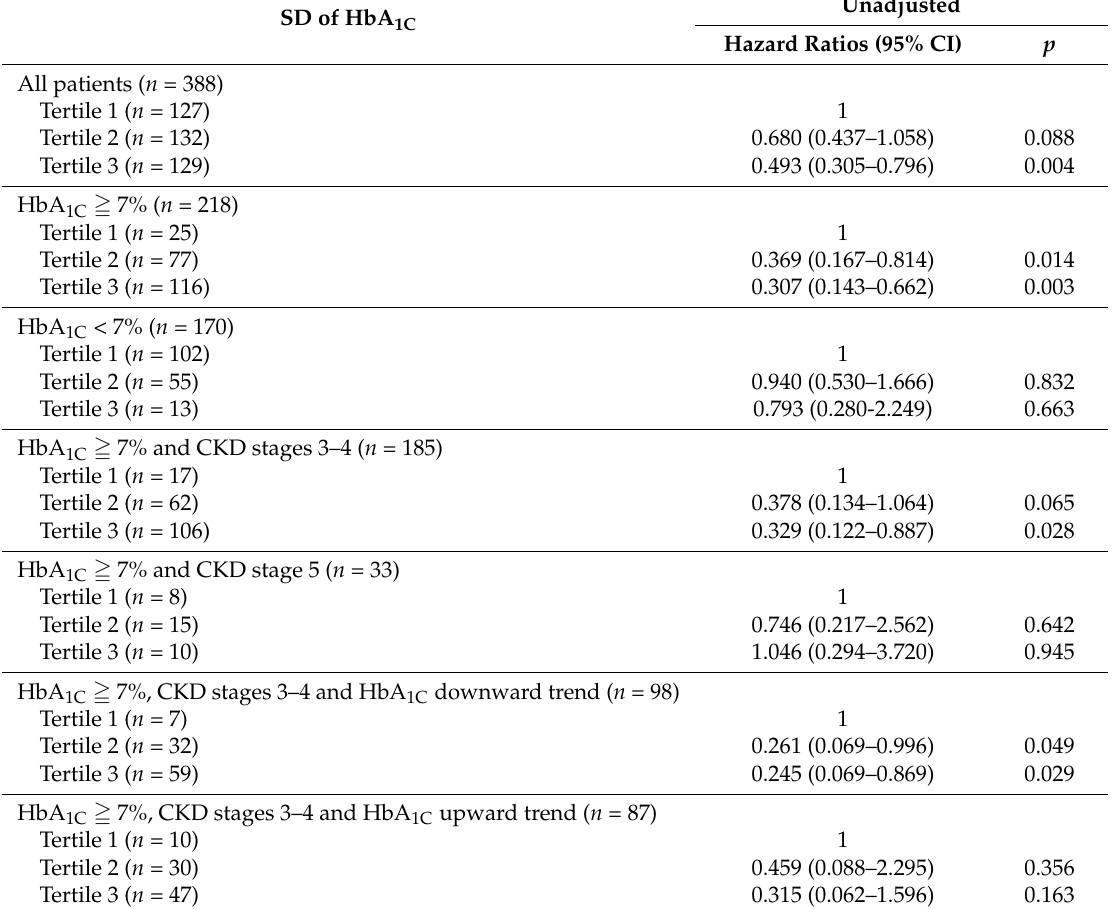
Table 2. Relation of SD tertile of HbA 1C for progression to dialysis using univariate Cox proportional hazards model among different